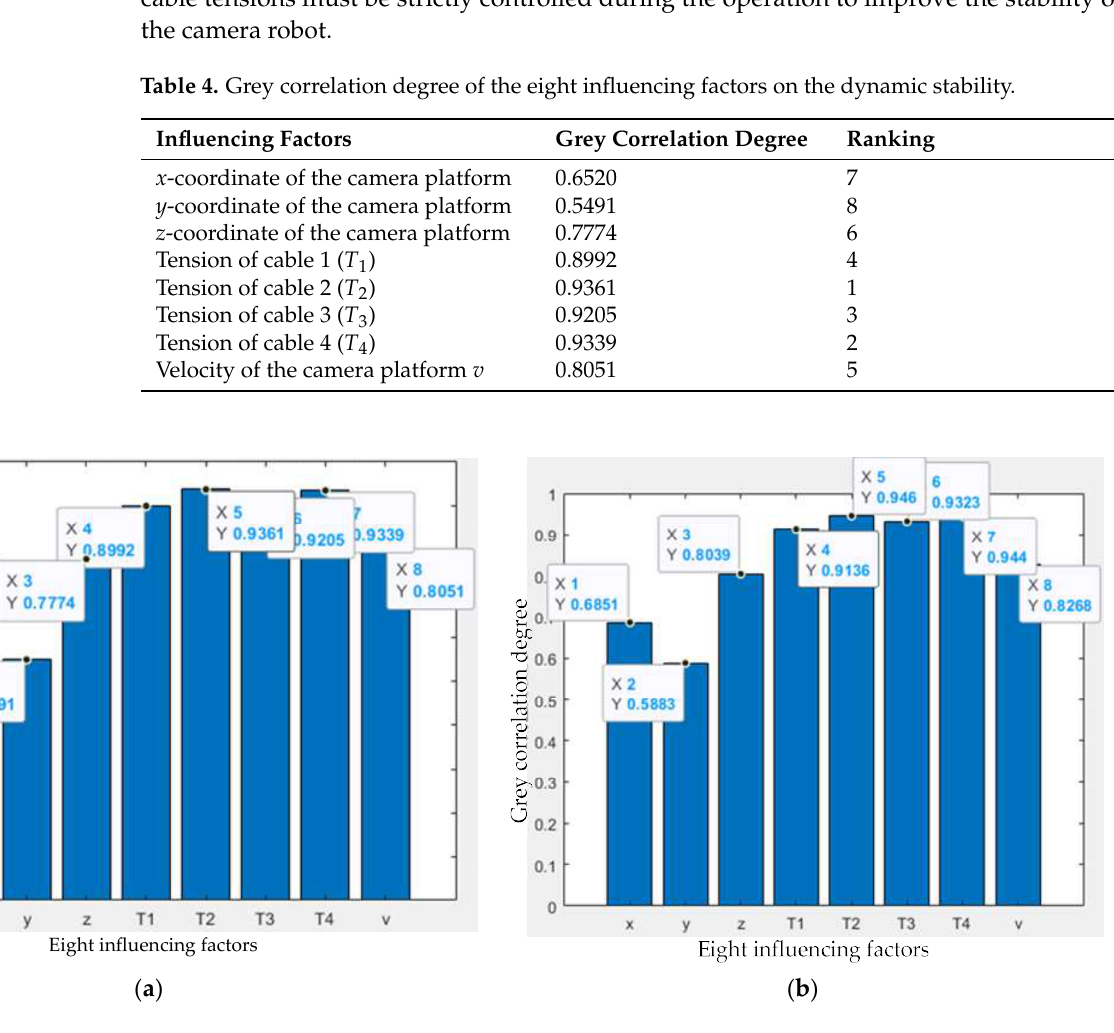
Table 4. Grey correlation degree of the eight influencing factors on the dynamic stability.